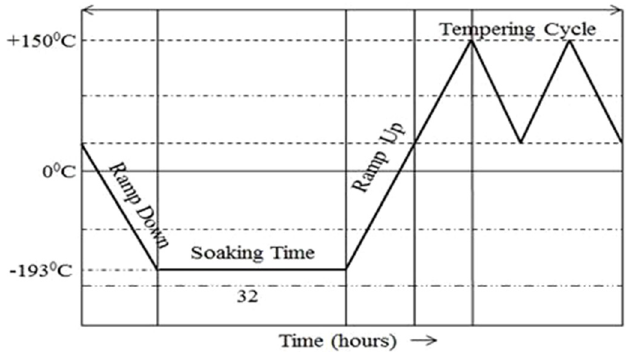
Fig. 3. Deep cryogenic treatment cycle with double